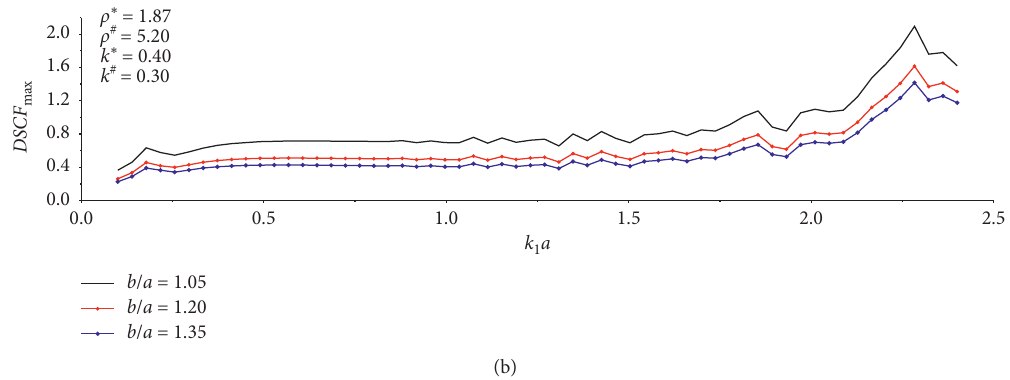
Figure 12: Variation of DSCF (b). Condition B-Q345: inner